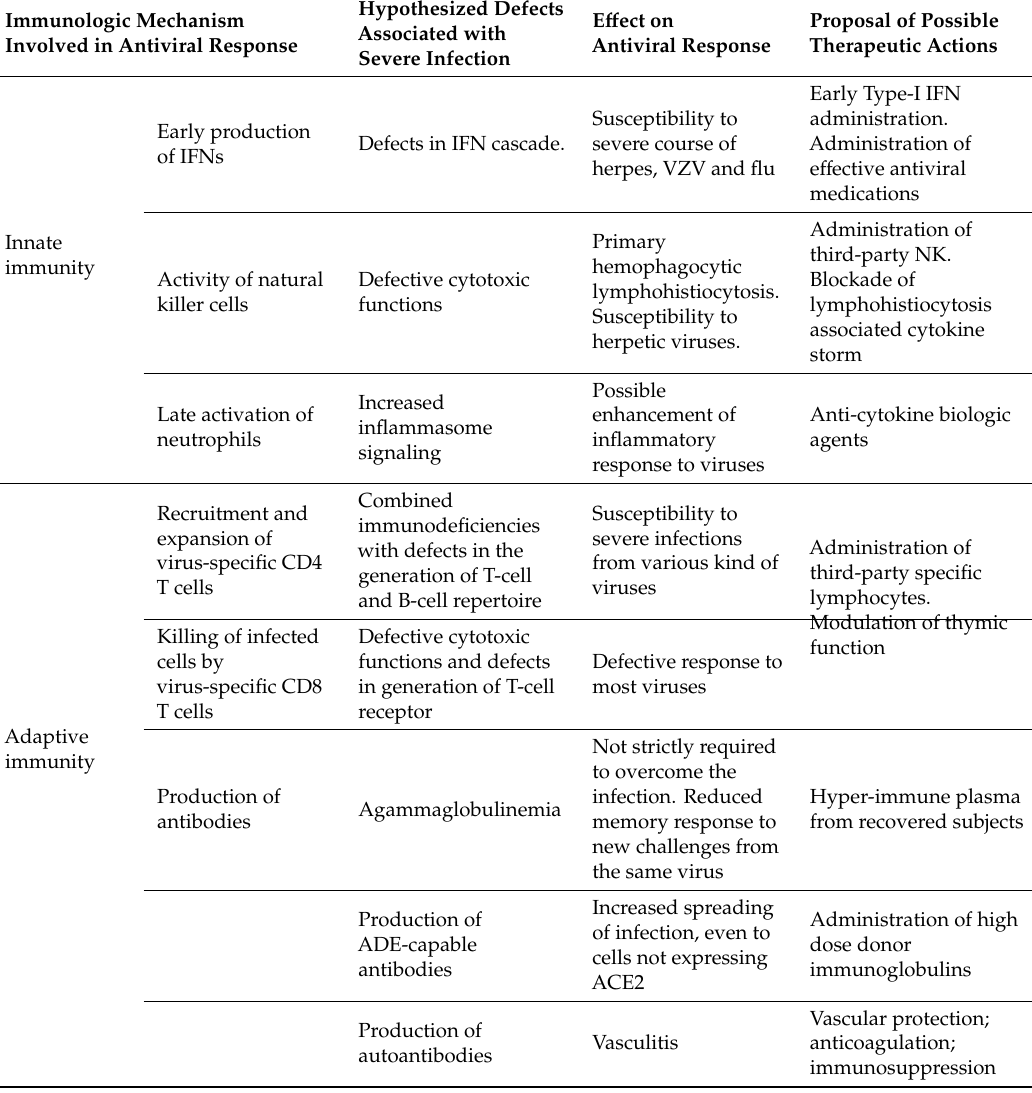
Table 1. Critical mechanisms of potential relevance as targets of